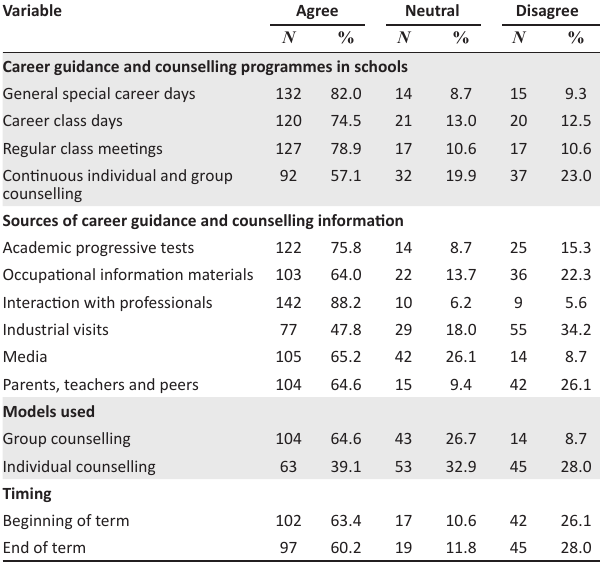
TABLE 1: Career guidance and counselling programmes, sources of information, models and